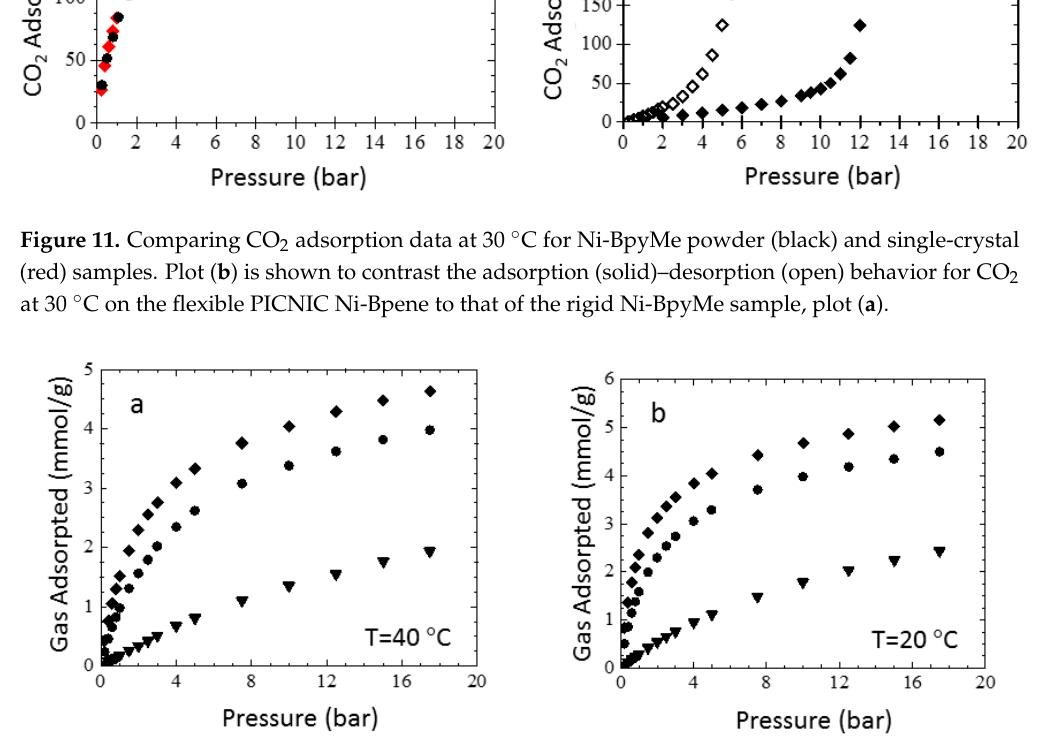
Figure 12. Adsorption data for CO 2 (diamonds), CH 4 (circles) and N 2 (triangles) at 40 ◦ C ( a ) and at 20 ◦ C on a crystalline sample of Ni-BpyMe ( b